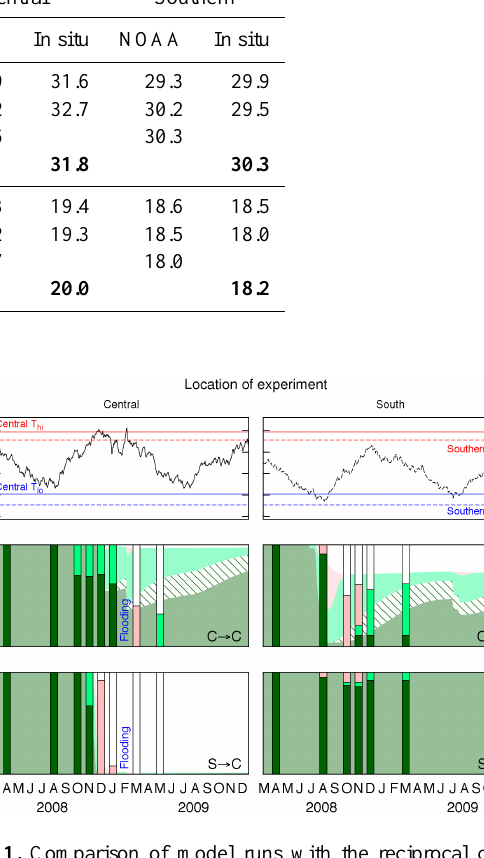
Figure 10. Comparison of model simulated beaching with that ob- served by Baird and Marshall (2002) on the Great Barrier Reef in 1998. Colour scheme as in Fig. 2.